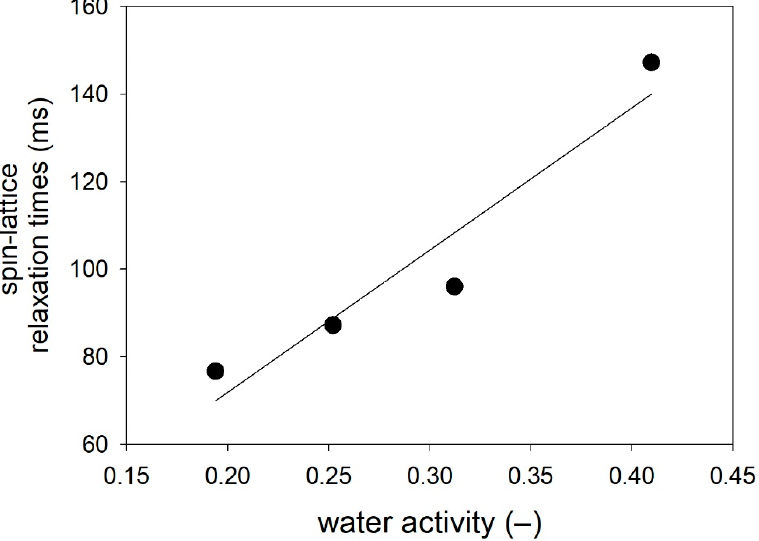
Figure 4. Correlation between water activity and spin–lattice relaxation times T 1 (Pearson r = 0.900; p = 0.050).